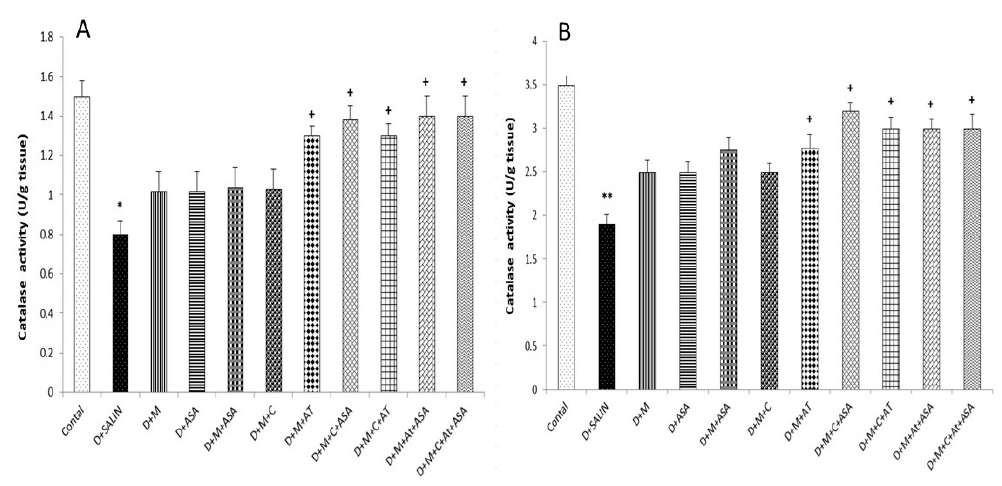
Data are shown as mean ± SEM. ** p < 0.01 compared to control group, + p < 0.05 and ++ p < 0.01